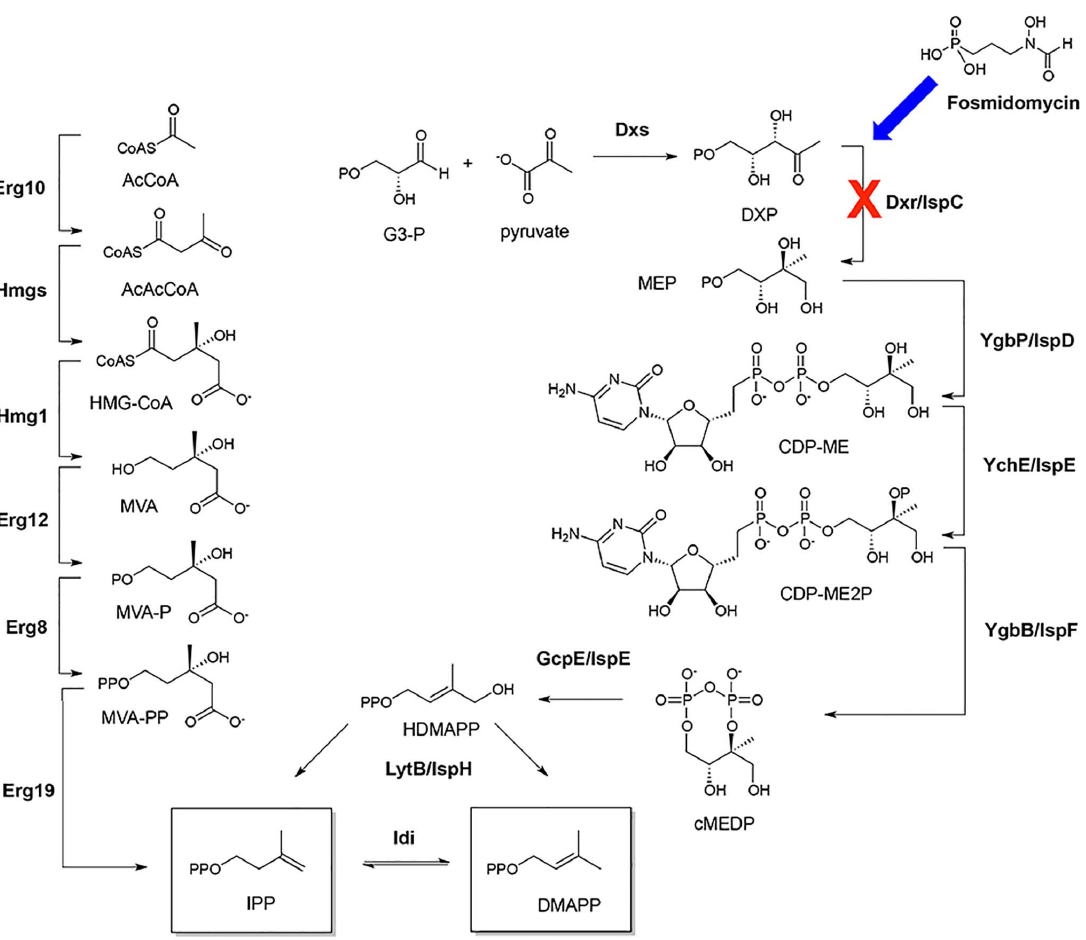
Figure 1. Biosynthesis of isopentenyl diphosphate (IPP) and dimethylallyl diphosphate (DMAPP). IPP and DMAPP are formed through the mevalonate pathway (left) in mammals, fungi and plants and through the methylerythritol phosphate (MEP) pathway (right) in many bacteria, green algae, and plant chloroplasts. Fosmidomycin inhibits formation of IPP and DMAPP (and thus late stage isoprenoid compounds) through disruption of the MEP pathway.